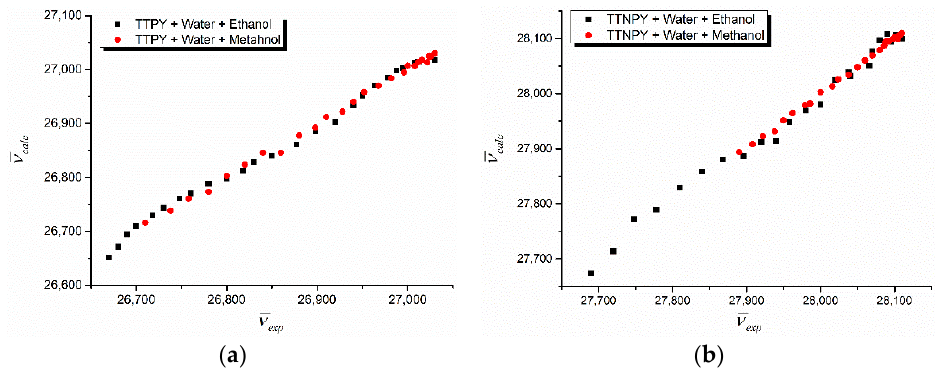
Figure 7. Computed wavenumber vs. experimental wavenumber for binary solvent mixture solutions of 4-tolyl-1,2,4-triazol-1-ium phenacylid (TTPY) ( a ) and 4-tolyl-1,2,4-triazol-1-ium-4 ’ -nitro-phenacylid (TTNPY) ( b ).